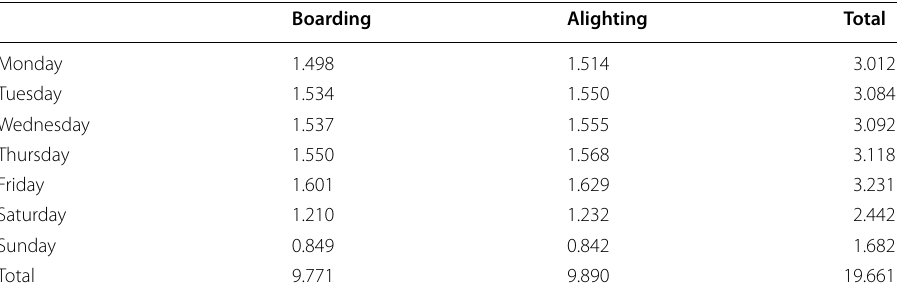
Table 1 Daily total number of passengers (in units of million people) for Subway Line #2 in Seoul Boarding